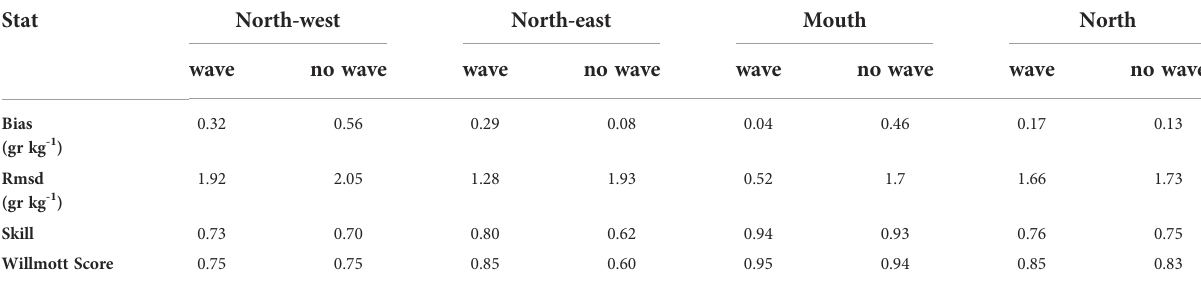
TABLE 3 Mean statistical indicators for salinity, with and without waves, in the outer zone and at the mouth of the MRE. North-west